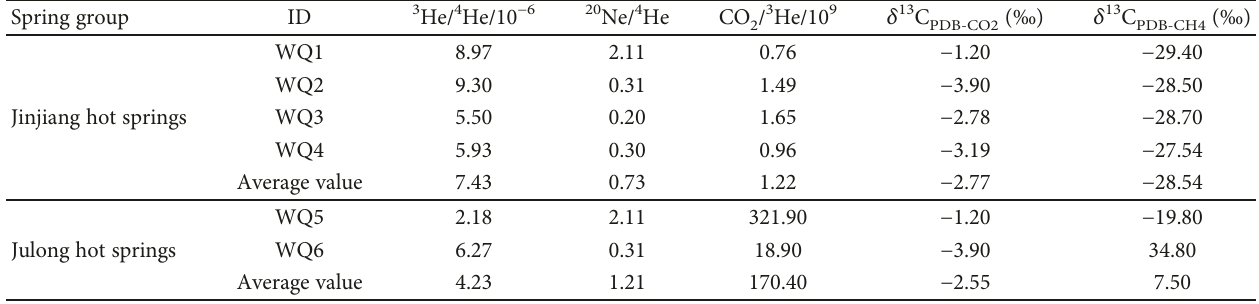
Table 4: Gas isotope (carbon and helium) characteristics of the Jinjiang and Julong hot springs. Spring group